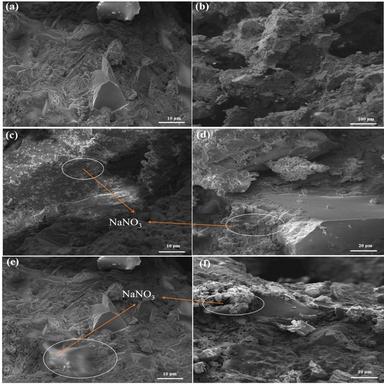
SEM images of (a, b) SSM and the composite materials with NaNO3 contents of (c, d) 40 % and (e, f) 50 %.